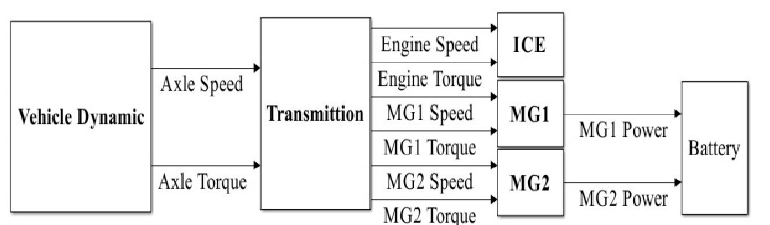
Figure 2. Two-mode powertrain simulation model.